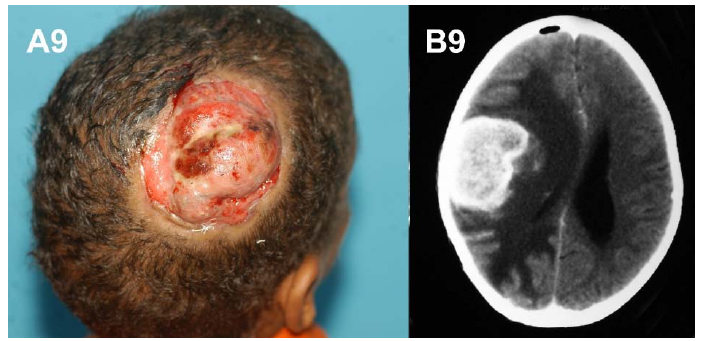
Figure 9. ( A ) massive head eumycetoma. ( B ) CT scan showing intra-cranial extension.